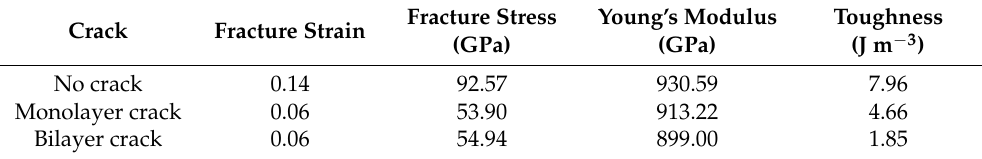
Table 5. Circular crack (D = 10 Å ).